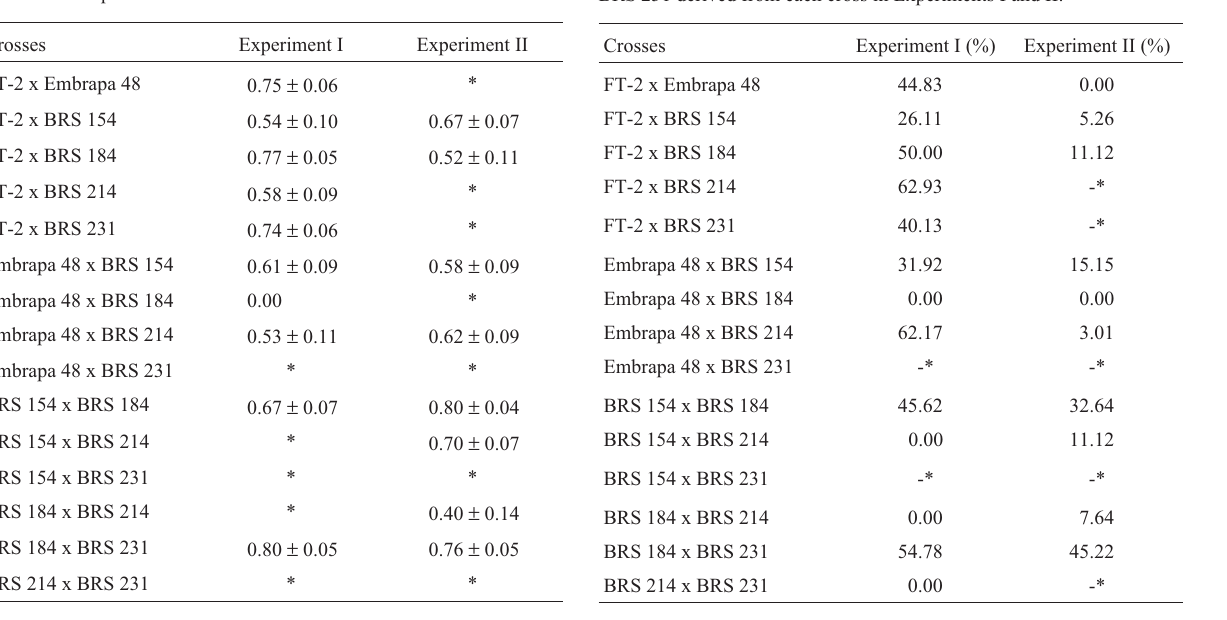
Table5 -Expectedpercentageofrandominbredlineshigheryieldingthan n ) based on F 3 family BRS 231 derived from each cross in Experiments I and II.